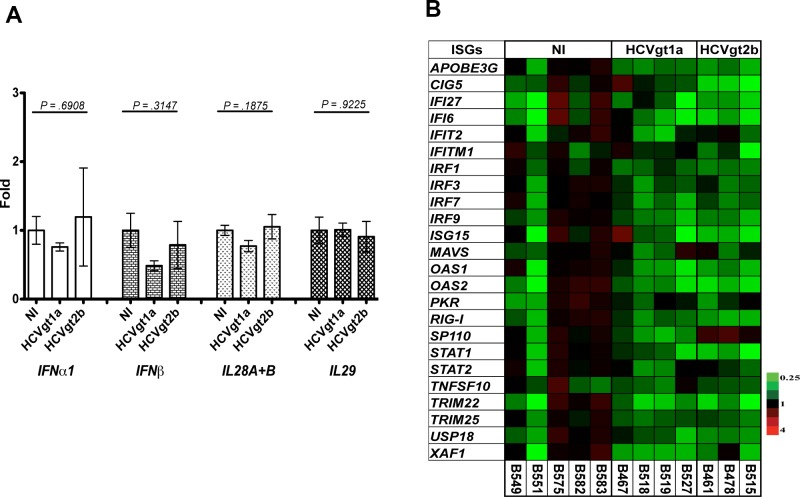
Intrahepatic IFN or ISG expression in mice infected with the two HCV strains.We infected chimeric mice produced with hepatocytes from donor Hu8063 with either HCVgt1a or HCVgt2b. Seven weeks p.i., we euthanized the mice and determined the expression levels of human-specific endogenous IFN genes (A) and ISGs (B) relative to a house-keeping gene HPRT-1 using the 2-ΔΔCt method. In uninfected donor-matched chimeric mice, the mean value of each gene mRNA level was normalized to 1. Data in A are mean ± the standard error of the mean (SEM); n = 3 to 5. We determined P-values using a one-way ANOVA calculation. In B, each column represents an experimental mouse. Increased and decreased expression of specific genes compared to the uninfected control group is shown in red (Fold >1 to ≥4) and green (Fold <1 to ≤0.25), respectively, whereas black indicates no change (Fold = 1).